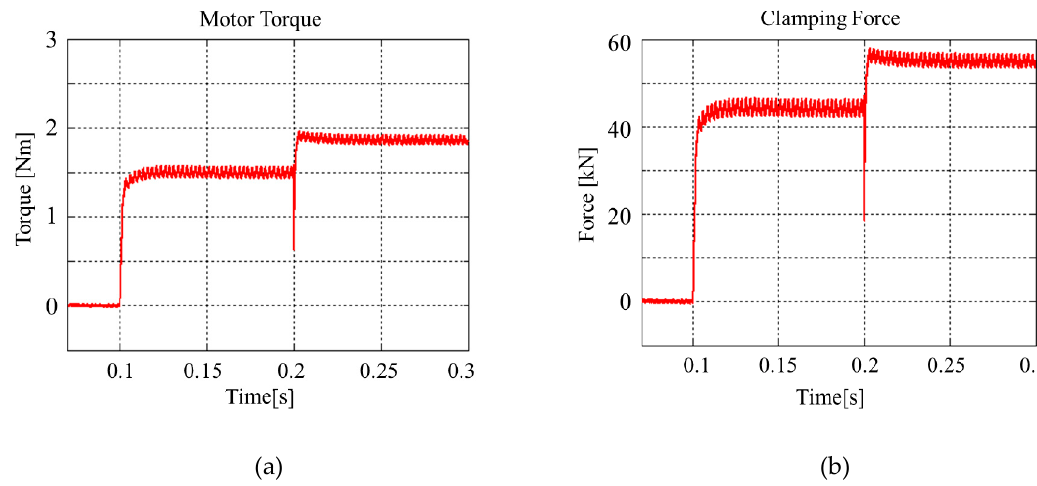
Figure 13. Motor torque and clamping force comparison between without MTPA and with MTPA: ( a ) motor torque and ( b ) clamping force. motor torque and ( b ) clamping